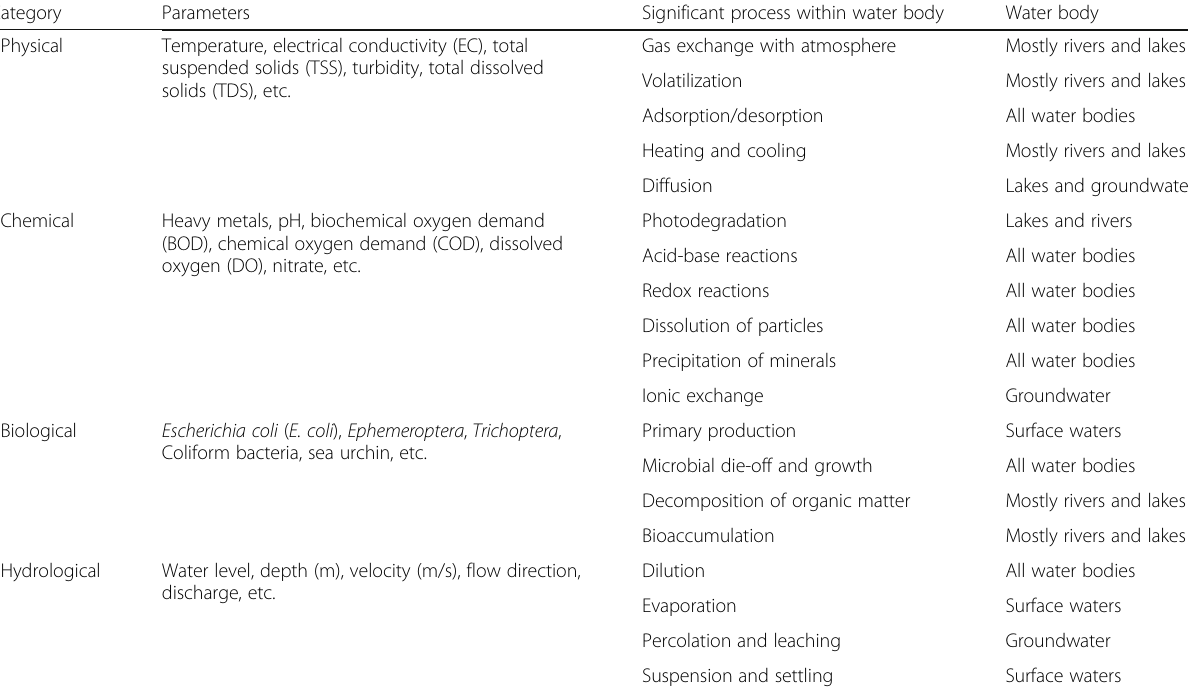
Table 2 Significant processes affecting water quality (modified from Bartram et al., 1996) Category Parameters Significant process within water body Water